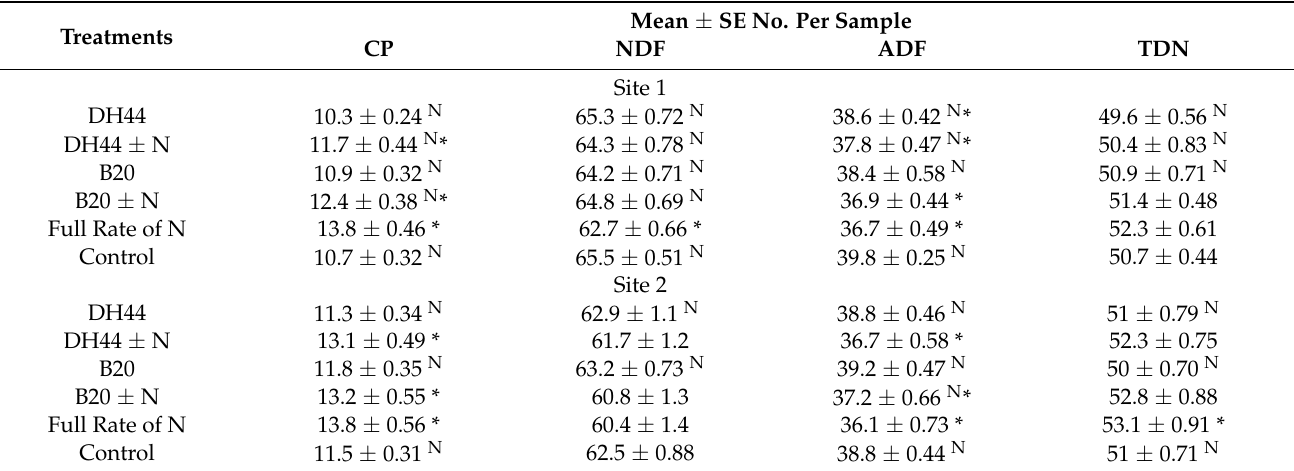
Table 1. Quality analysis for bermudagrass forage harvested from each site under conventional fertility or